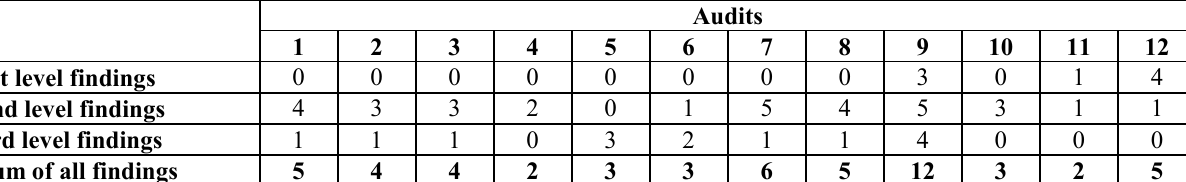
Fig 3. Checking of the compliance of organization with the requirements Table 2. The results of the YYY organization department internal audits